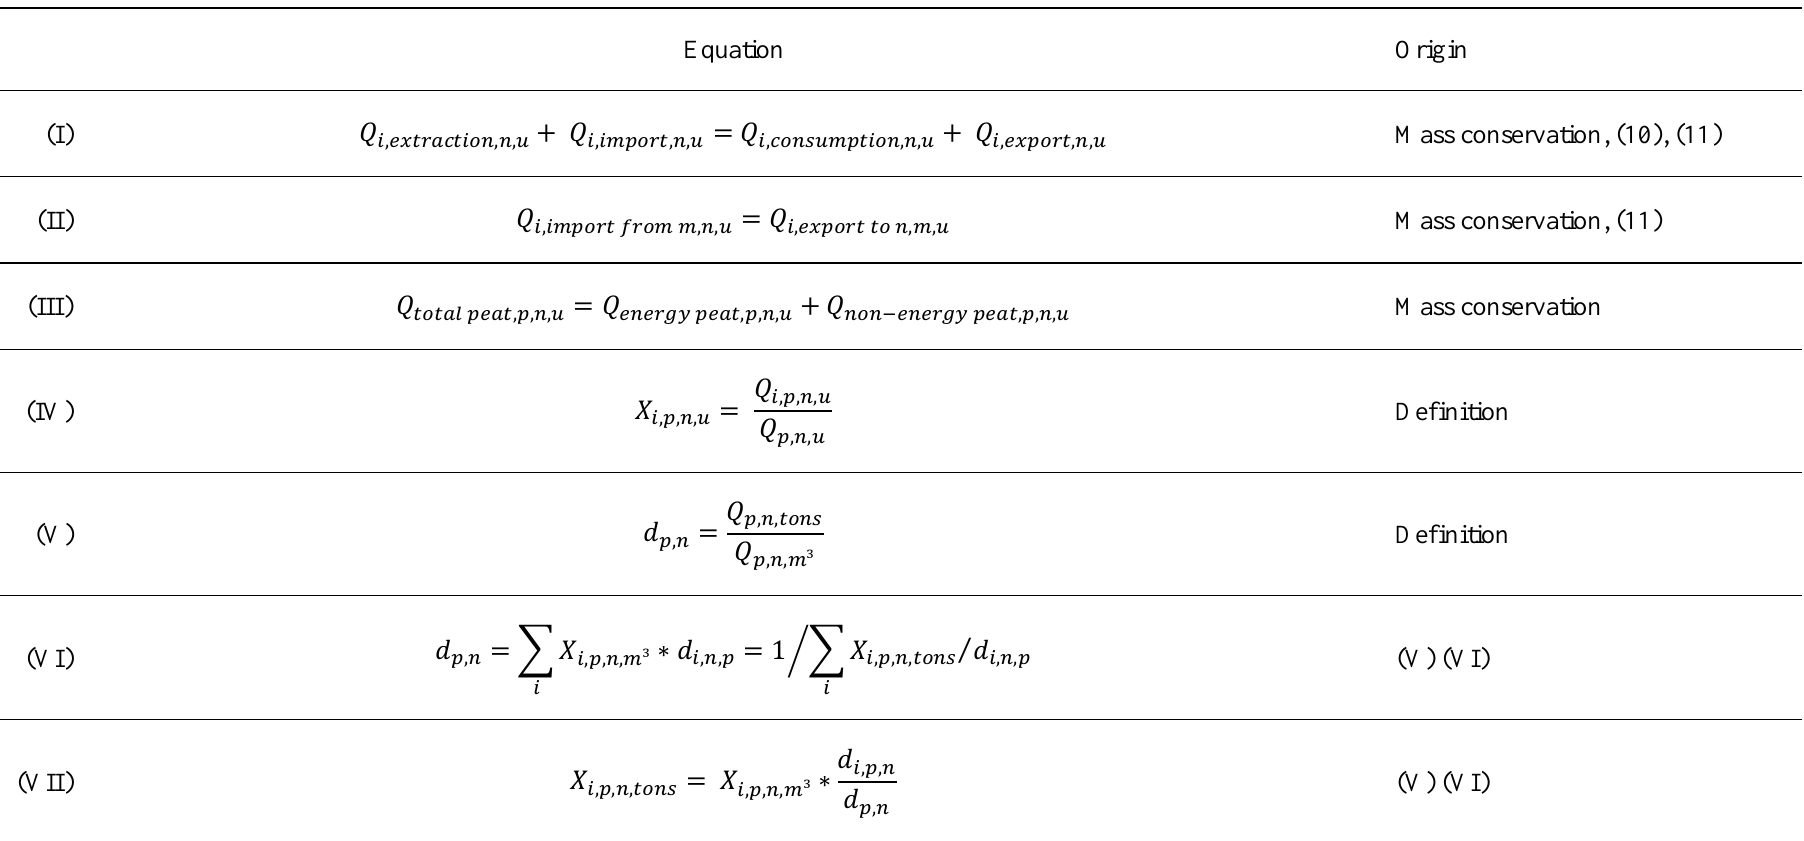
Table A3. Equations used for the model resolution for each flow 𝑝 , each country 𝑛 , each element 𝑖 and each unit 𝑢